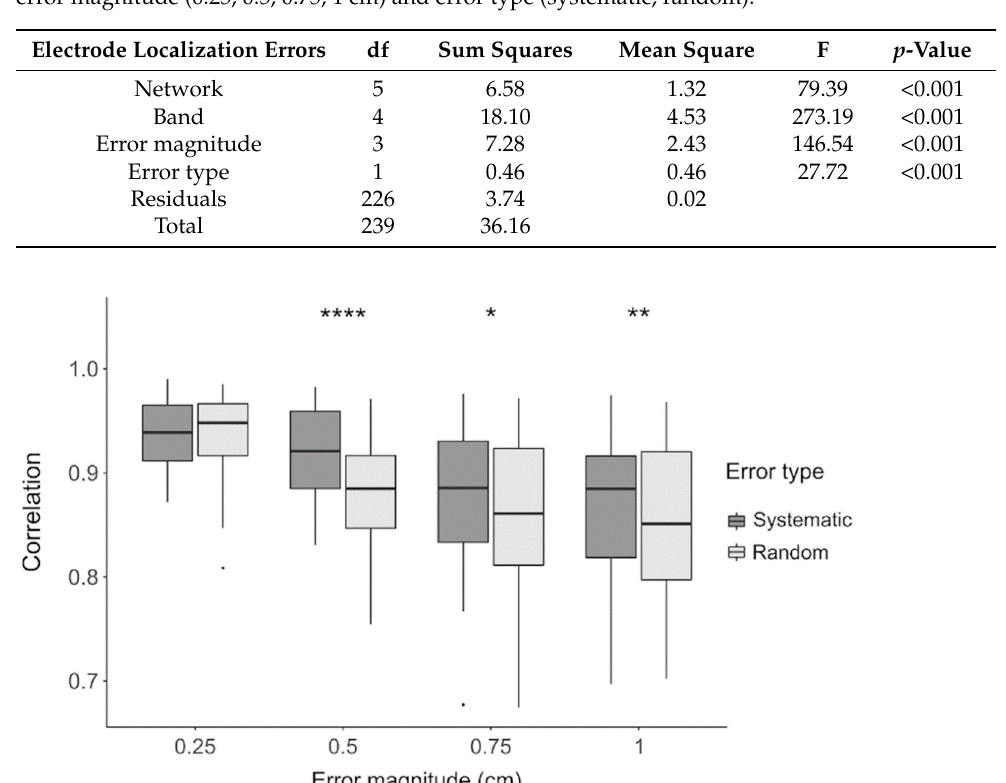
Figure 5. Intra- and inter-network connectivity differences per network and frequency band. A com- parison was performed by means of a Wilcoxon signed-rank paired test; the color bar represents the z-value obtained through the test, where the red colors stand for intra-network connectivity values higher than inter-network ones, and the blue colors vice-versa.